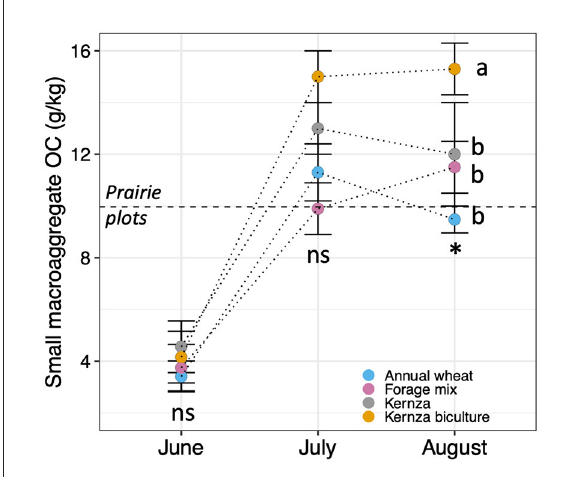
FIGURE2 Temporal variation in small macroaggregate OC under IWG (Kernza), IWG biculture, annual wheat or forage mix in the first year after site conversion. Horizontal line in denotes prairie plot small macroaggregate OC. Vertical bars indicate the standard error of the mean. For each month, ns, means do not differ significantly ( p > 0.05), * means differ at p < 0.05. Within each month, crops with same letter do not differ significantly at p < 0.05.